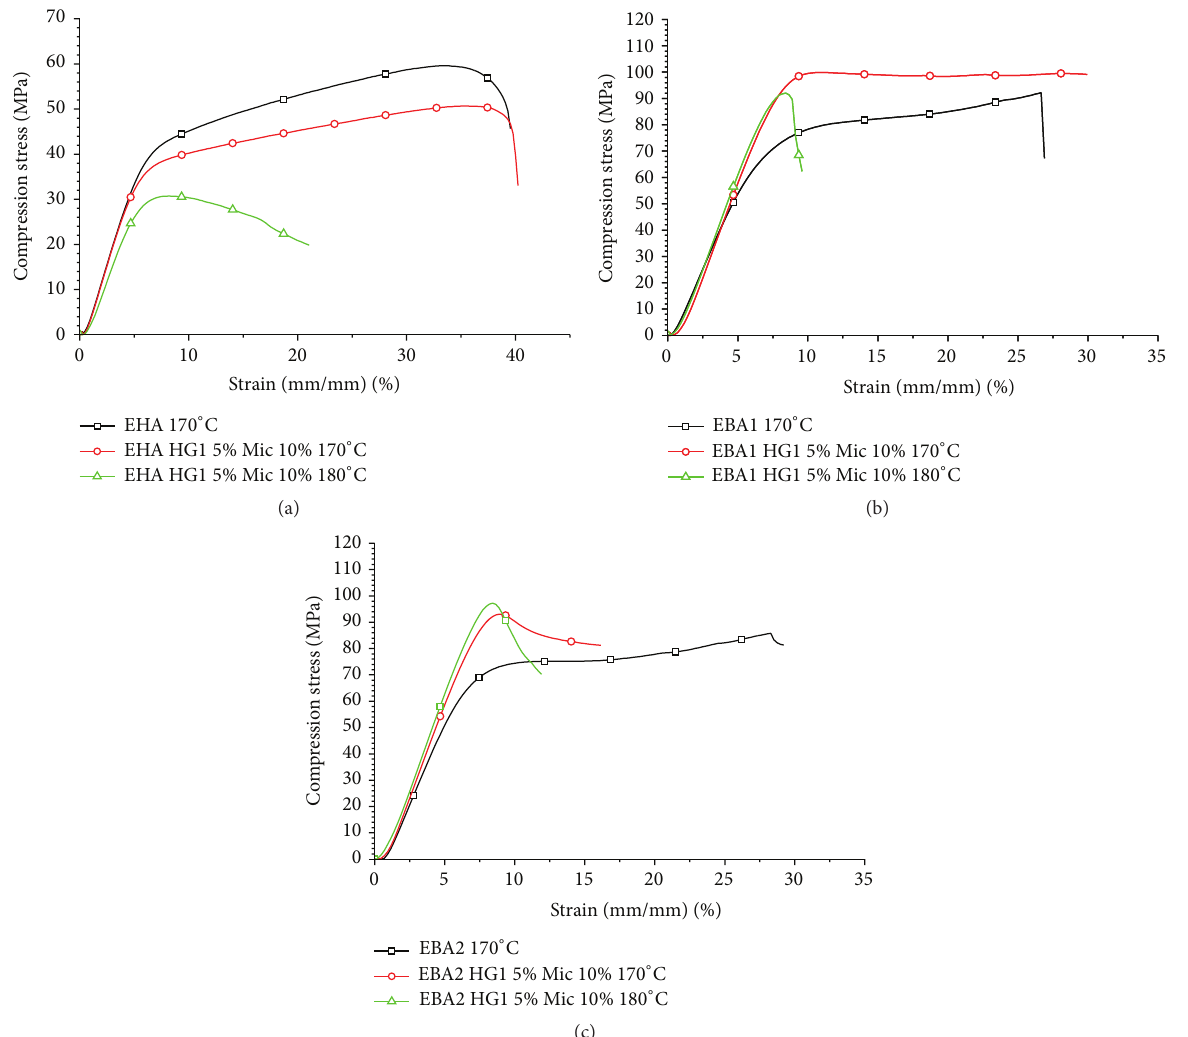
Figure 7: (a) Comparison of compressive stress-strain curves for neat EHA and for self-healing systems with EHA epoxy matrix, at the different curing temperature. (b) Comparison of compressive stress-strain curves for neat EBA1 and for self-healing systems with EBA1 epoxy matrix, at the different curing temperature. (c) Comparison of compressive stress-strain curves for neat EBA2 and for self-healing systems with EBA2 epoxy matrix, at the different curing temperature.